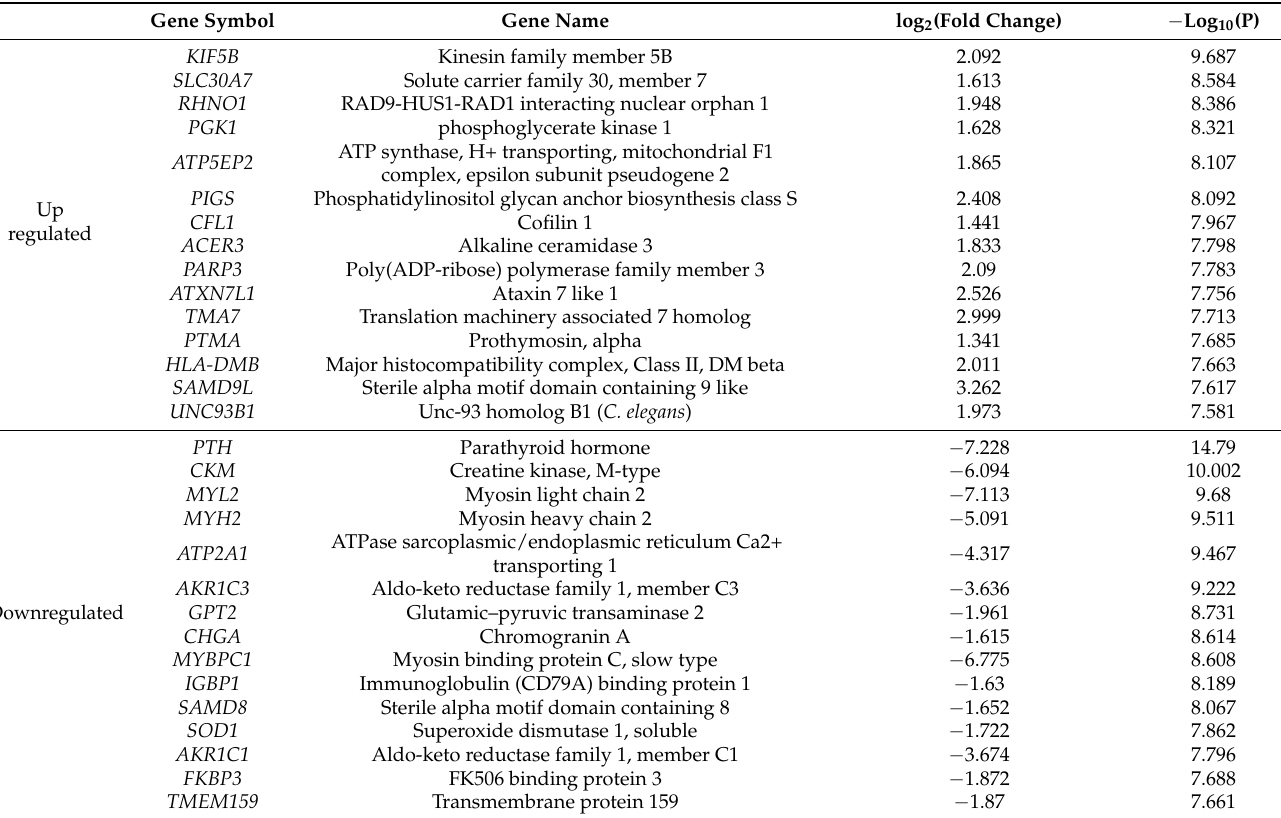
Table 1. List of top 15 up- or downregulated differentially expressed genes (protein-coding genes only). Genes with |Log 2 (FC)| > 1 and p -value < 0.05 were considered to be